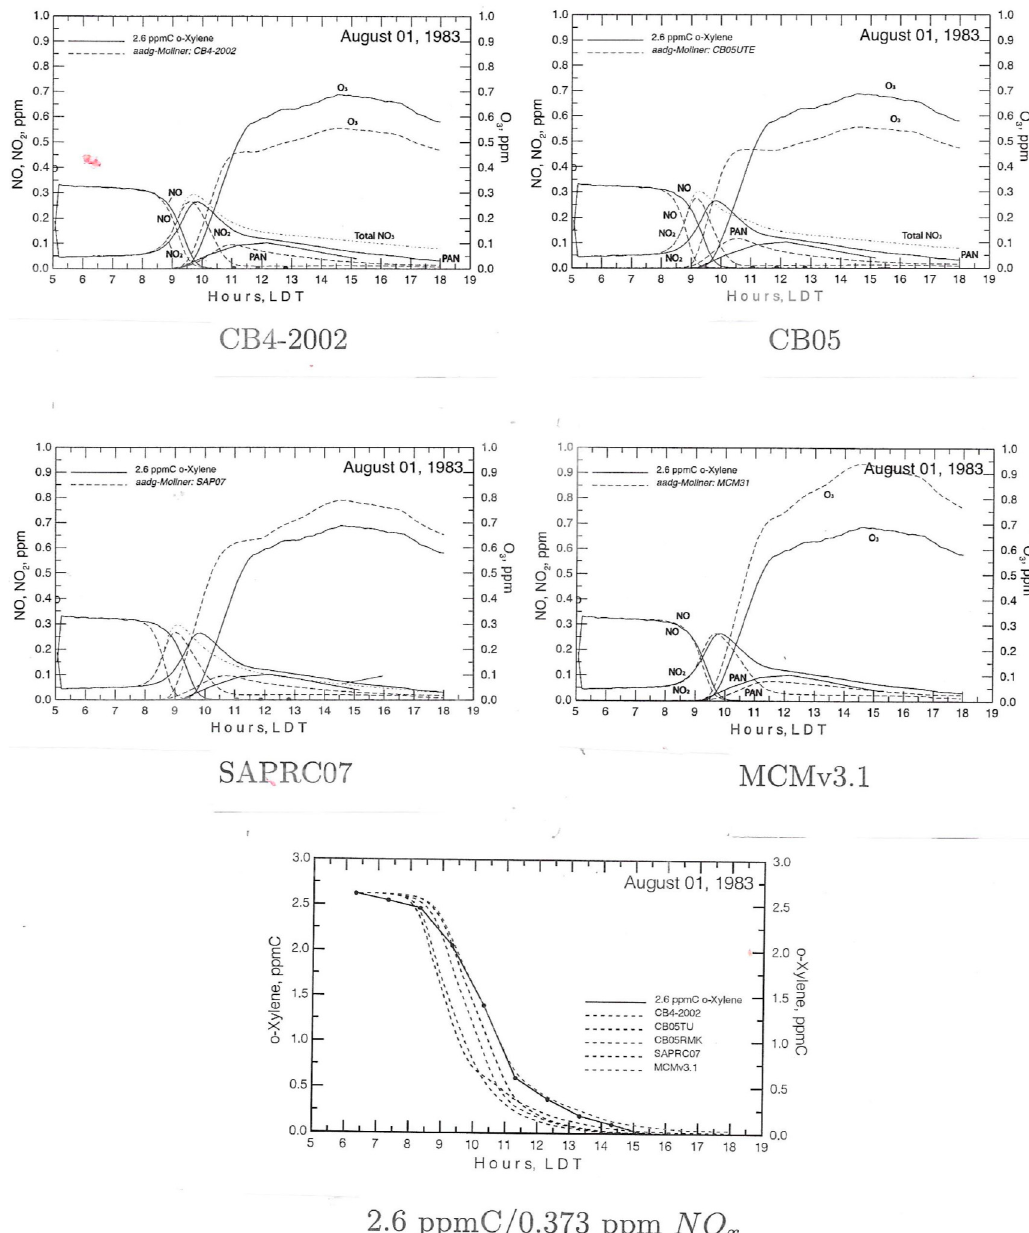
Figure 4. Smog chamber time series including a gas-phase reaction sequence of NO x and m-xylene, August 1, 1983, comparing data from the UNC outdoor chamber with CB04-2002, CB05, SAPRC-07 and MCMv3.1 calculations. The solid lines are the observations. Dotted lines are the model calculations (reprinted from [176], with permission from CSIRO publishing).